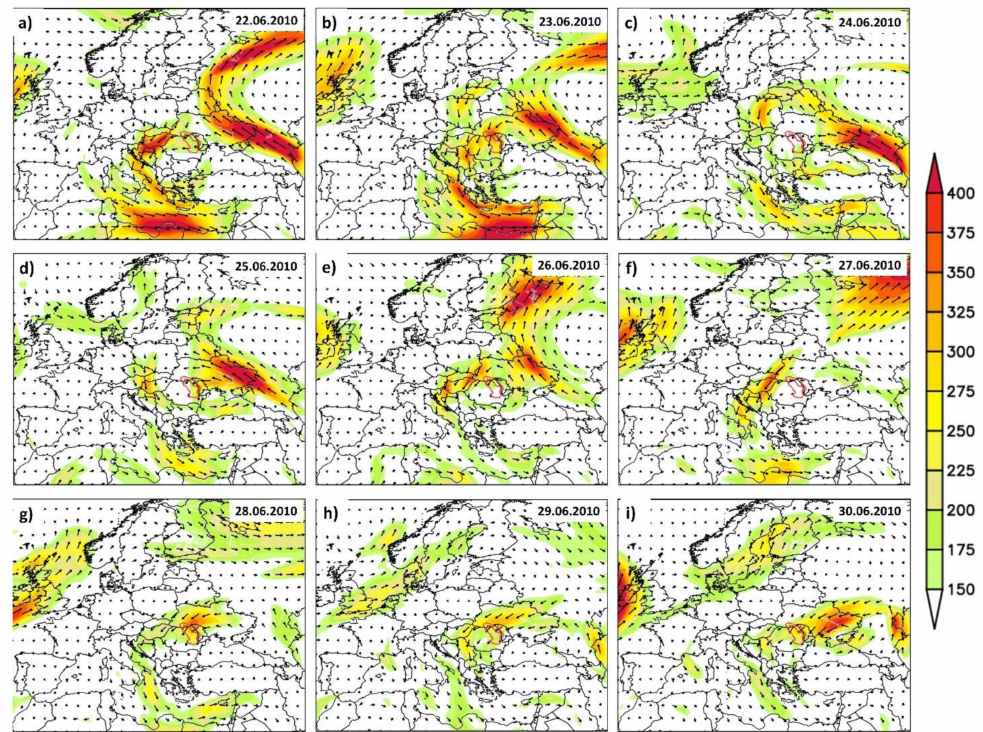
Figure 8. Magnitude (shaded colors) and direction (vectors) of the daily integrated water vapor transport (WVT) for: ( a ) 22 June 2010; ( b ) 23 June 2010; ( c ) 24 June 2010; ( d ) 25 June 2010; ( e ) 26 June 2010; ( f ) 27 June 2010; ( g ) 28 June 2010; ( h ) 29 June 2010; and ( i ) 30 June 2010. Units: WVT (kg · s − 1 · m − 1 ).